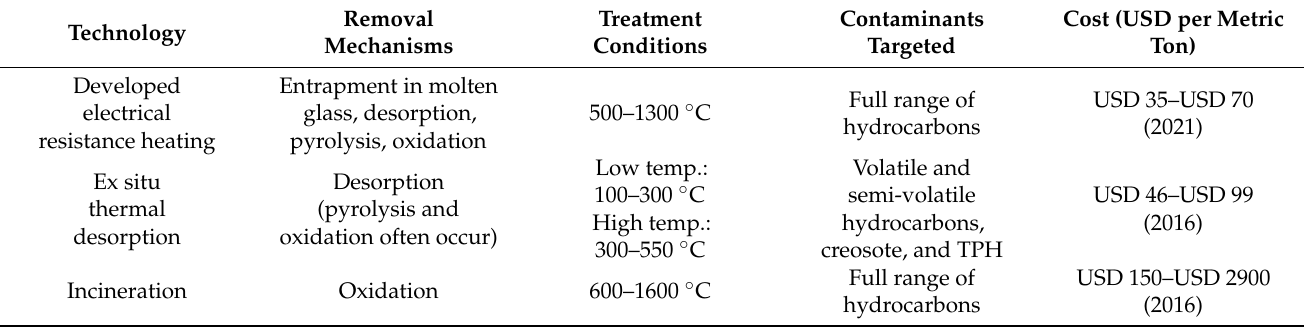
Table 7. Comparison of remediation costs with thermal treatment methods (based on